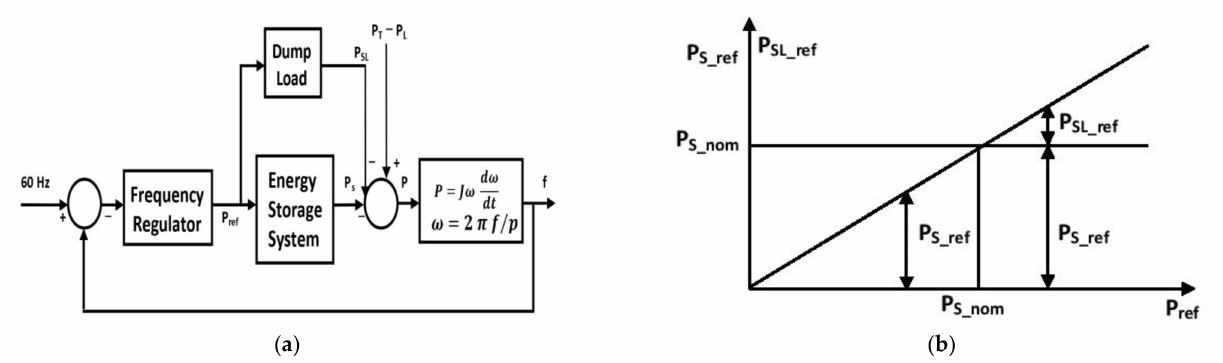
Figure 6. ( a ) Frequency control scheme of the WDHPS system. ( b ) Power-sharing strategy between the BESS and SL .